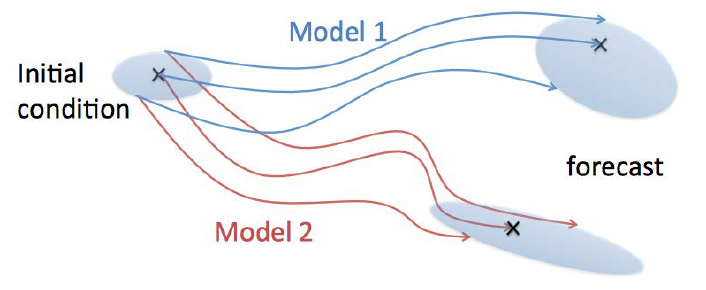
Figure 2 : The Hawkmoth Effect. With a perfect estimation of the uncertainty around the initial condition, only a perfect model can result in a perfect specification of the uncertainty in the forecast. An imperfect model may be arbitrarily wrong even when initialised ideally. Note that identical initial conditions have finite separation immediately under Model 1 and Model 2; chaotic divergence identical initial conditions remain identical for all